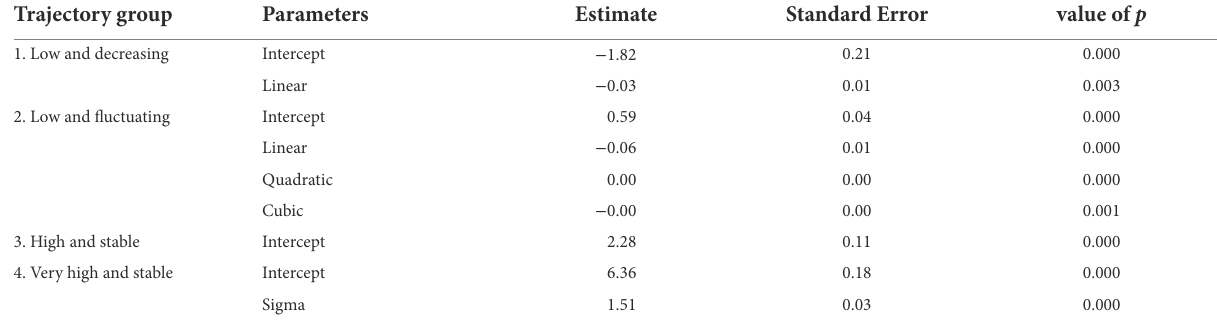
TABLE 6 Coefficients estimates for the group-based trajectory